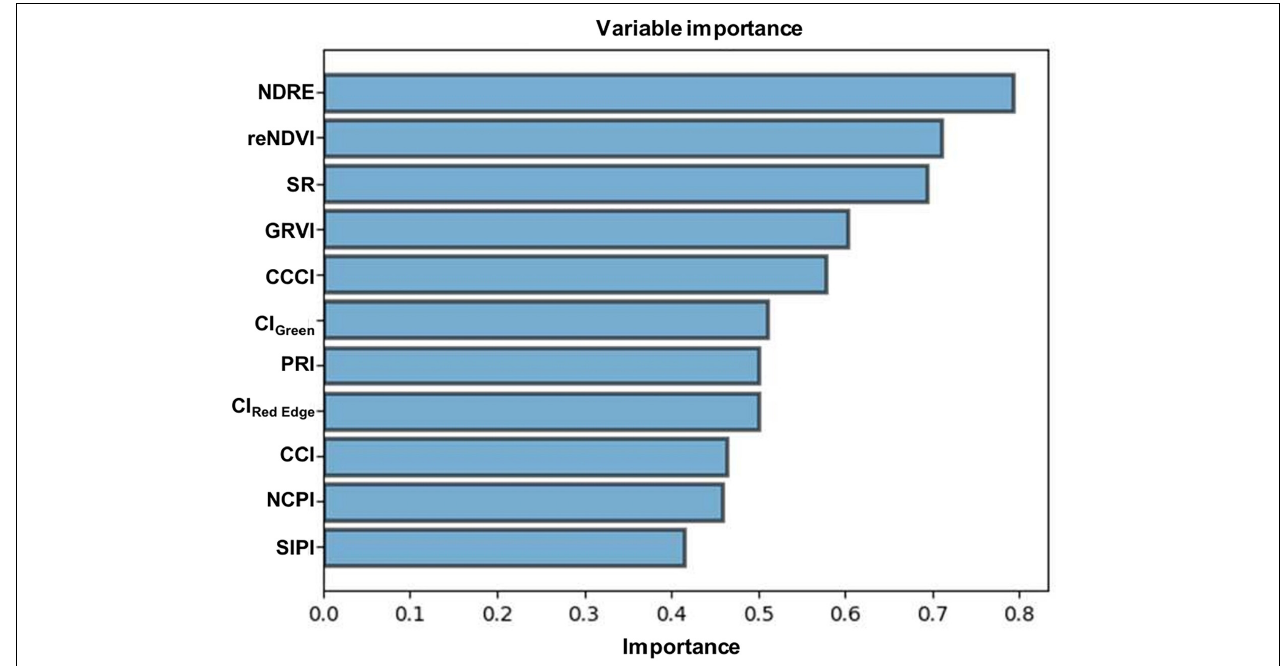
FIGURE 5 | Independent variables with their respective importance